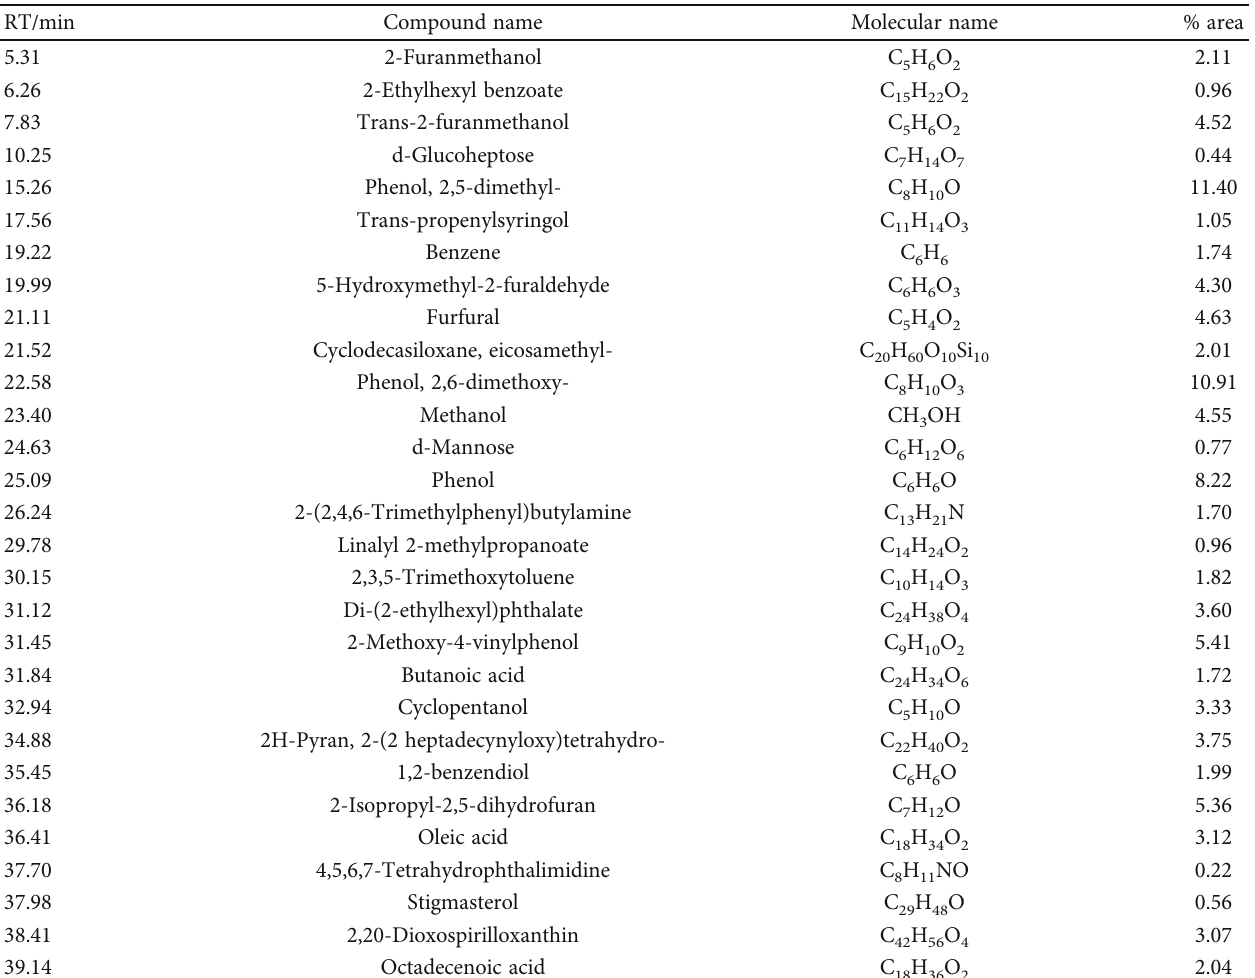
Figure 8: FTIR analysis of the bio-oil obtained from hardwood + corncob. Table 6: GC-MS analysis of the bio-oil produced from hardwood +